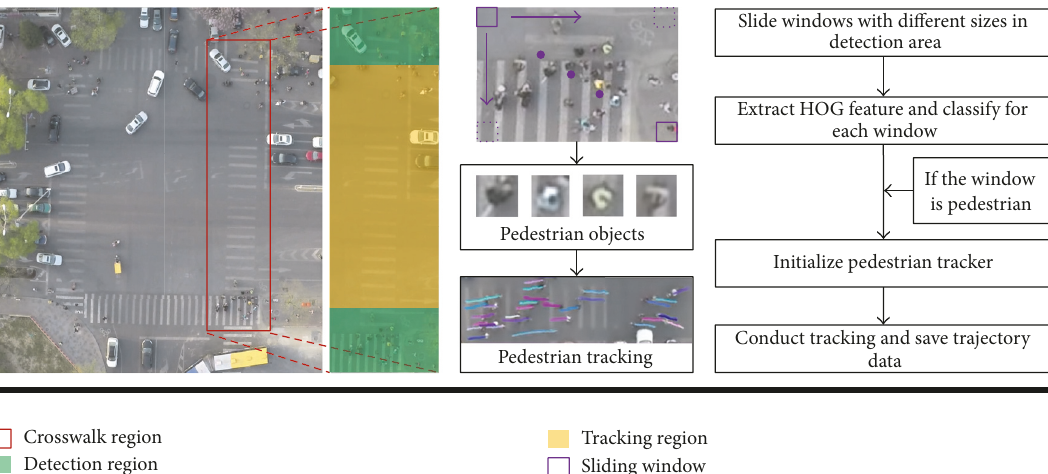
Figure 3: The workflow of pedestrian detection and